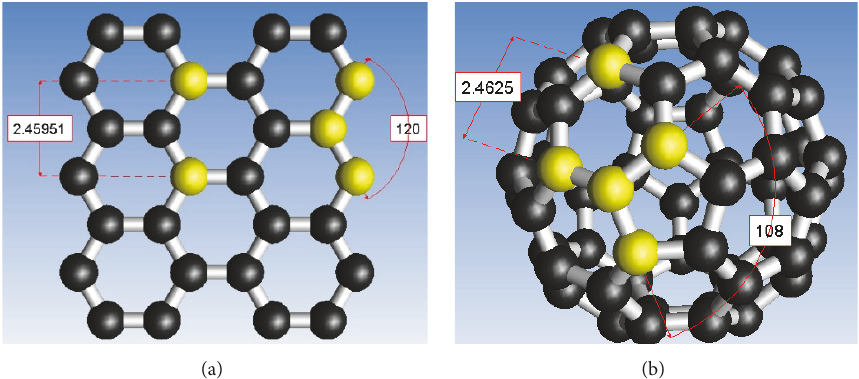
Figure 28: Measurement of bond angle and bond length.